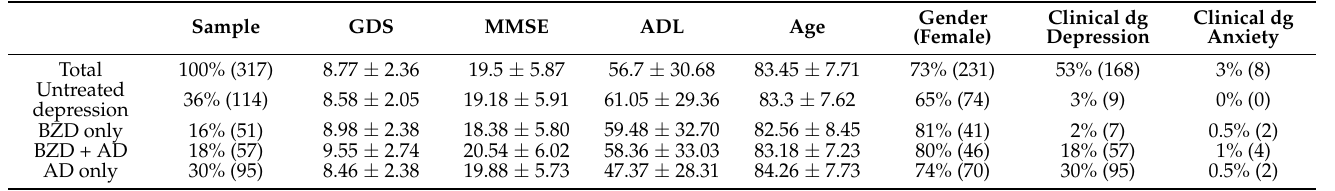
Table 1. Characteristics of the sample (means ± SD, or %( n